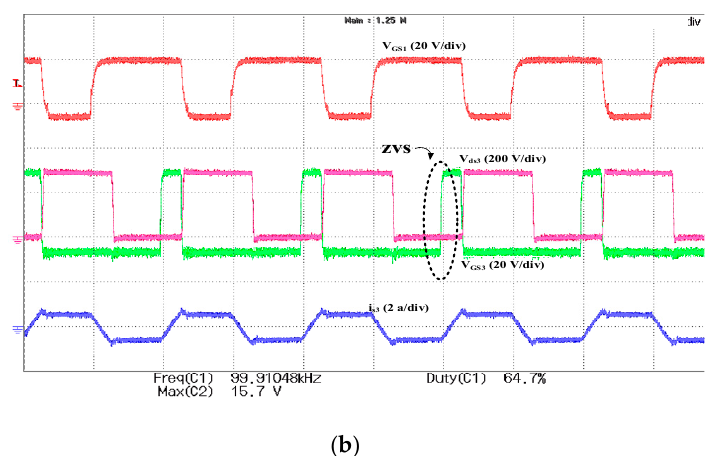
Figure 19. Experimental results for v in = 12 V at full load: ( a ) gate-to-source voltage V Gs 1 ( 20 V /div ) , current across primary-side MOSFET i s 1 (20 A / div), and voltage V AB = 50 V / div; ( b ) gate-to-source voltage V GS 3 (20 V / div), drain-to-source voltage V ds 3 (200 V / div), and current across secondary-side MOSFET i s 3 (2 A / div).